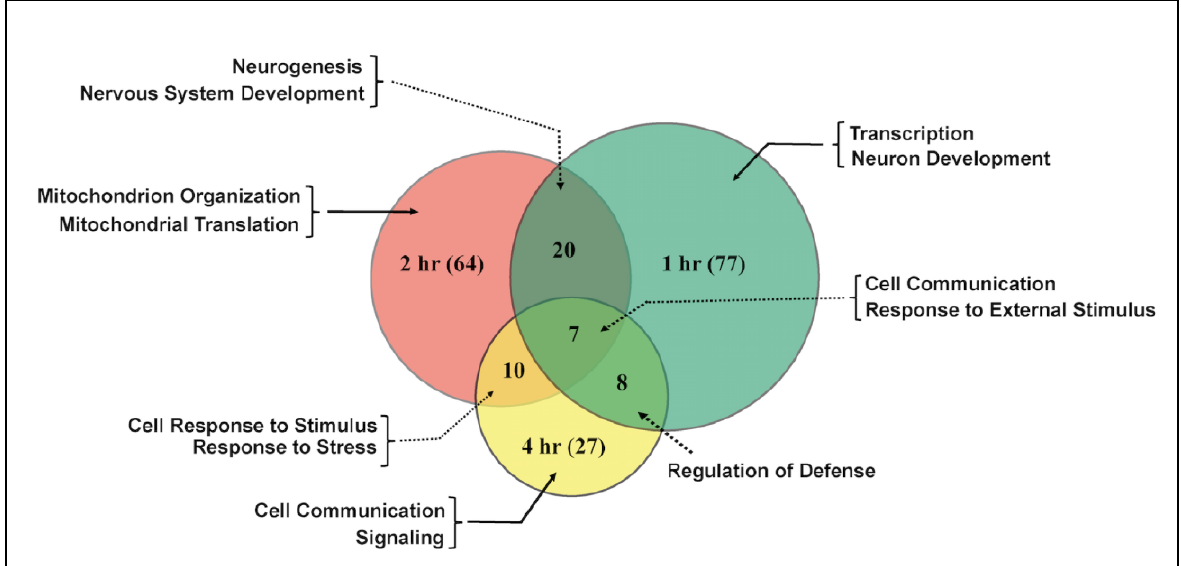
Figure 4. Shared gene ontology (GO) terms in tau -KO males across time-points after injury. Significant genes identified from sequencing were classified for their biological functions using RDAVID. The Venn diagram shows significantly changed GO terms for tau -KO males at 1, 2 and 4 h after injury as well as overlap between time-points. The number of GO terms differentially regulated at each time-point is indicated in parenthesis.